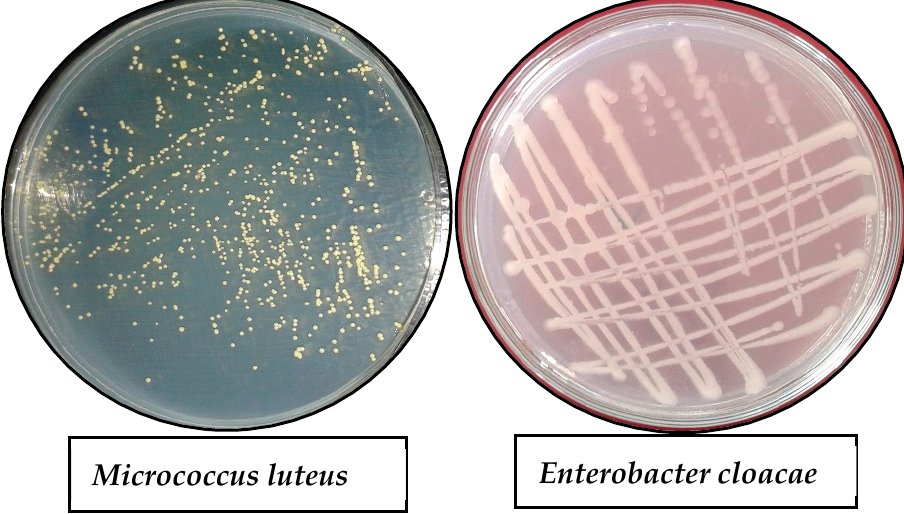
Figure 1. NA plates of two heavy metal tolerant strains, Micrococcus luteus , and Enterobacter cloacae . The two bacteria demonstrated higher tolerance to Cd and Ni at concentrations of 3.125, 6.25, 12.5, 25, and 50 µ M, while the growth of the two isolates was affected at 100 µ M. Based on this screening, the tolerable behavior for both bacteria showed more tolerance against Ni than Cd heavy metals. Therefore, depending on these results, the two isolates might enhance heavy metal tolerance and plant growth (Table